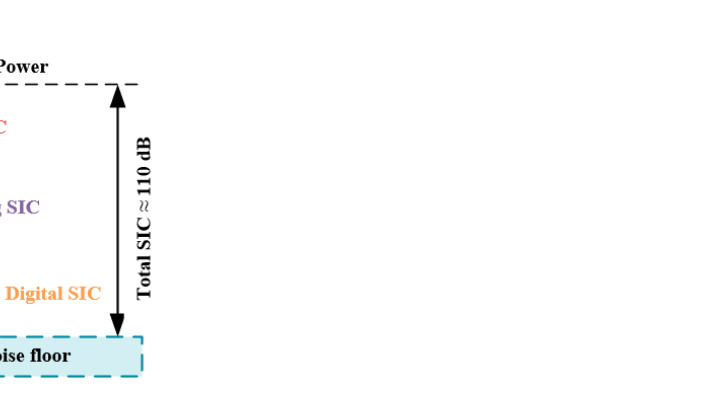
Figure 1. Total 110 dB self-interference cancellation (SIC) realized by SIC techniques in different domains.